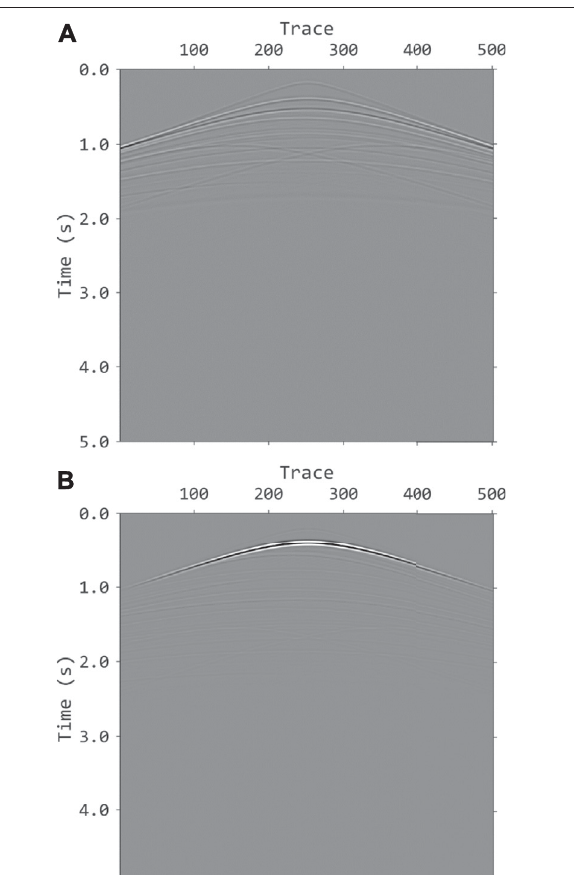
FIGURE 5 | The generated input data using Sigsbee 2A model for VSP imaging. (A) a common receiver gathers of VSP data containing primaries only. (B) Common receiver gathers of VSP data containing direct waves and free-surface – related